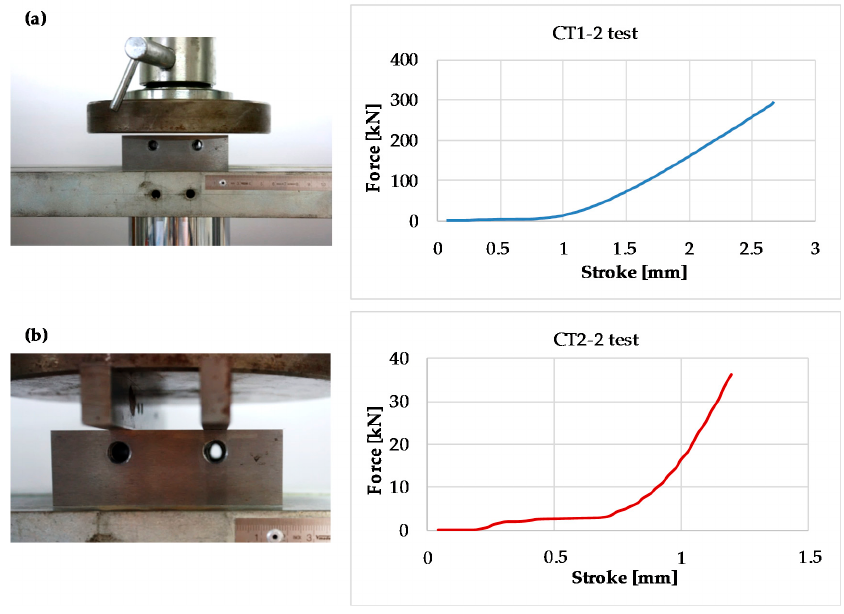
Figure 11. ( a ) CT1-2; ( b ) CT2-2 set-ups and results.